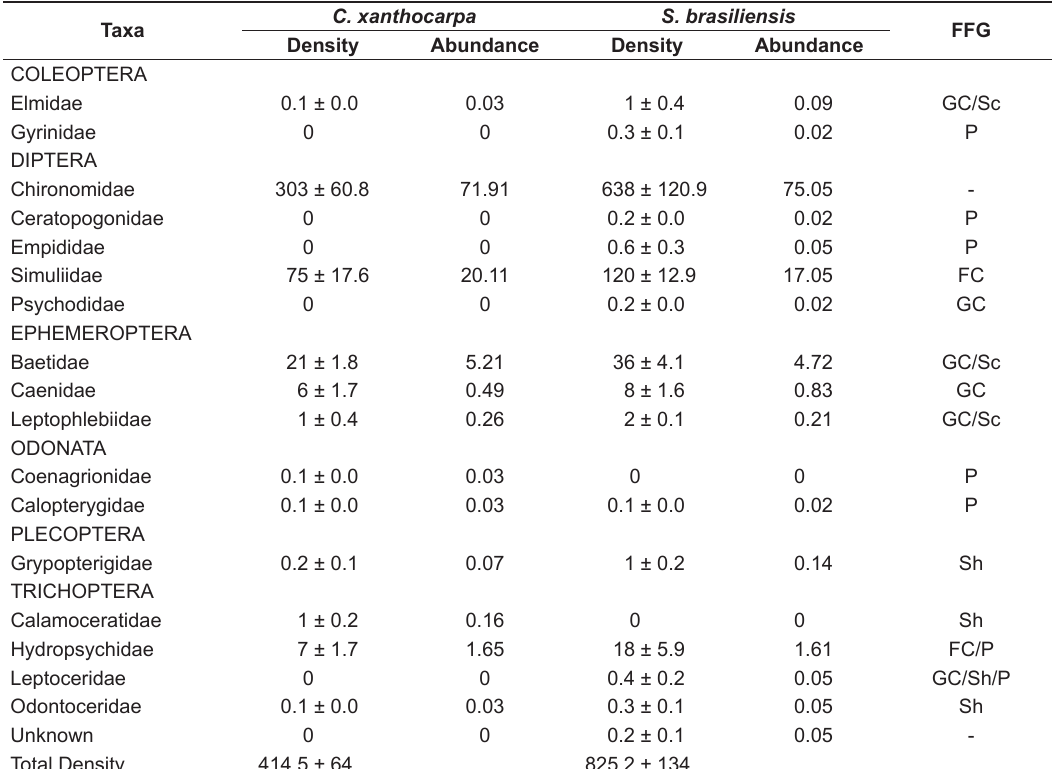
Table 3. Means ± SE combined over time of densities (individuals g –1 leaf dry mass), relative abundance (%) and cor- responding Feeding Functional Group (FFG) of total invertebrates associated on leaves of tree species in a subtropical stream .“-” = FFG not assigned, GC = gathering-collectors, FC = filtering-collectors, P = predators, Sc = scrapers, Sh =